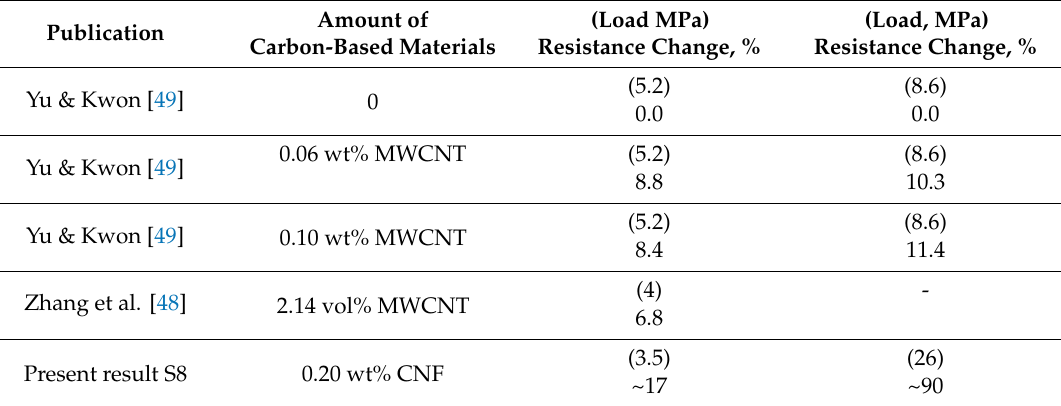
Table3. Loadsensitivityofcement / CNTcompositesmeasuredbyothersandcomparedwithrecalculated Table 3. Load sensitivity of cement/CNT composites measured by others and compared with results obtained for mix recalculated results obtained for mix S8.